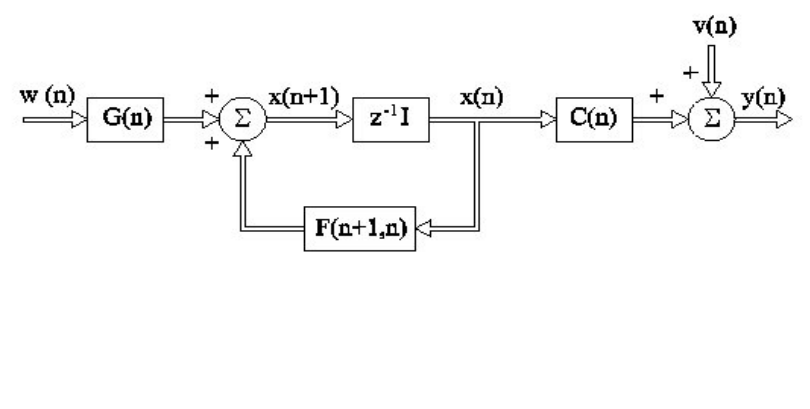
Figure 4. Basic signal